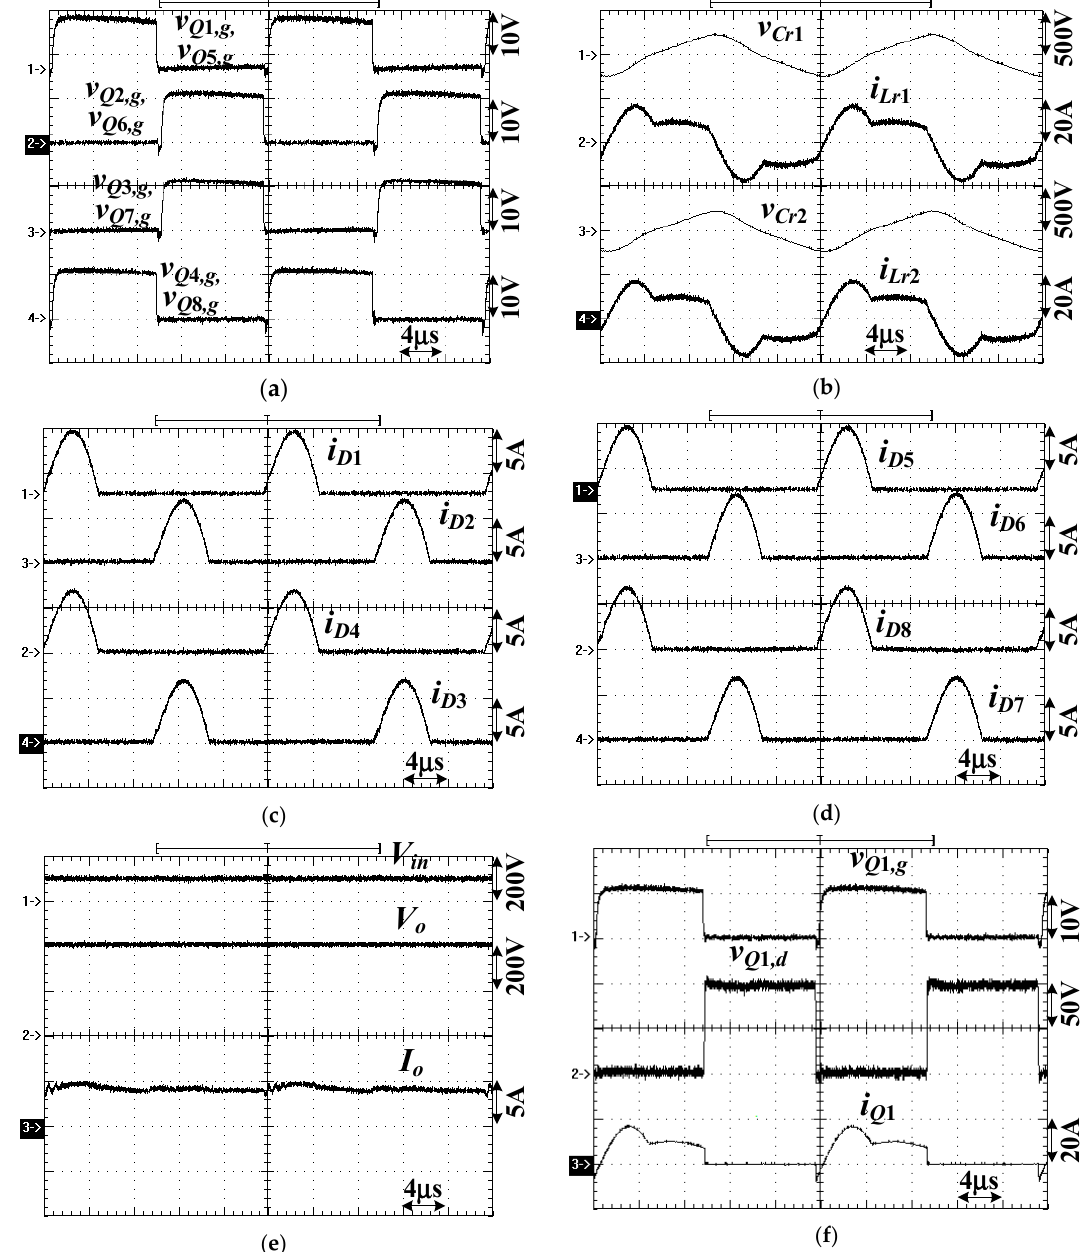
Figure 8. Experimental results at V in = 100 V (low voltage range) and 1.8 kW load. (a) v Q 1, g ~ v Q 8, g, (b) v Cr1 , i Lr 1 , v Cr 2 , i Lr 2, (c) i D 1 ~ i D 4, (d) i D 5 ~ i D 8, (e) V in , V o , I o, (f) v Q 1 ,g , v Q 1 ,d , i Q 1 .